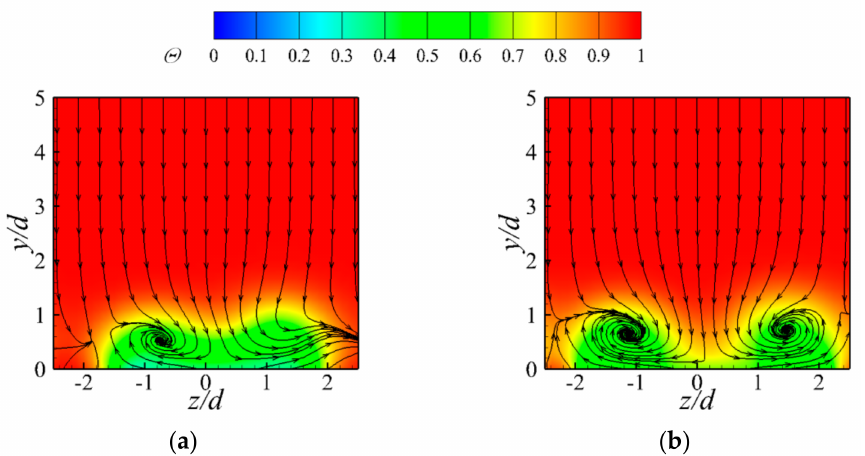
Figure 15. Dimensionless temperature contours and streamlines on a normal section of s/d = 18 on the pressure side under M = 1.5. ( a ) Z / d = 0.5 and β = 29 ◦ , ( b ) Z / d = 1.0 and β = 29 ◦